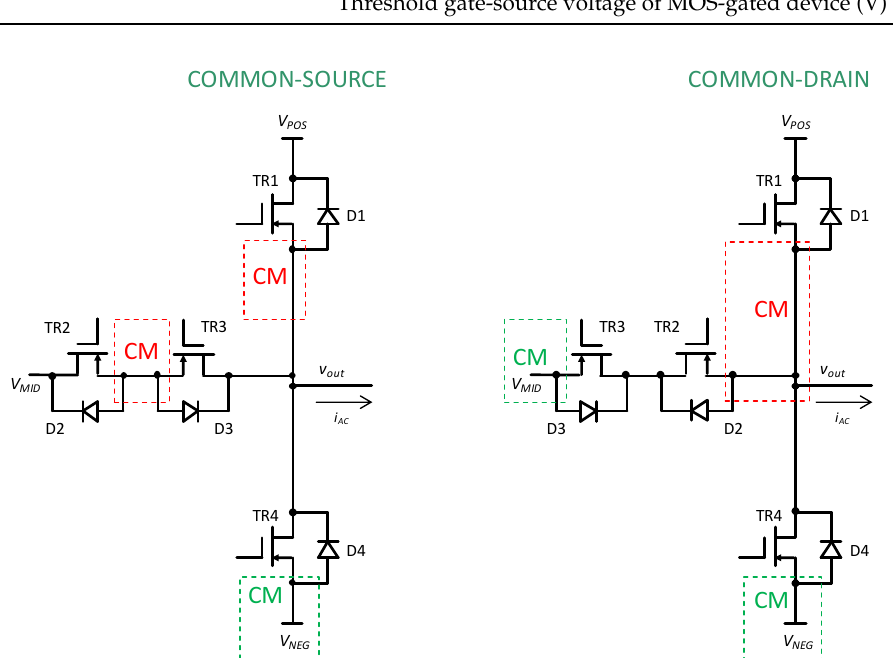
Figure 1. T-type converter bridge-leg shown with the central devices, TR2 and TR3, connected in common-source and common-drain configurations. JFETs are shown as the power devices. The diodes depicted are not discrete devices, but represent the JFETs’ equivalent intrinsic diode functionality when reverse-biased. Table 1. Principle symbols and abbreviations.